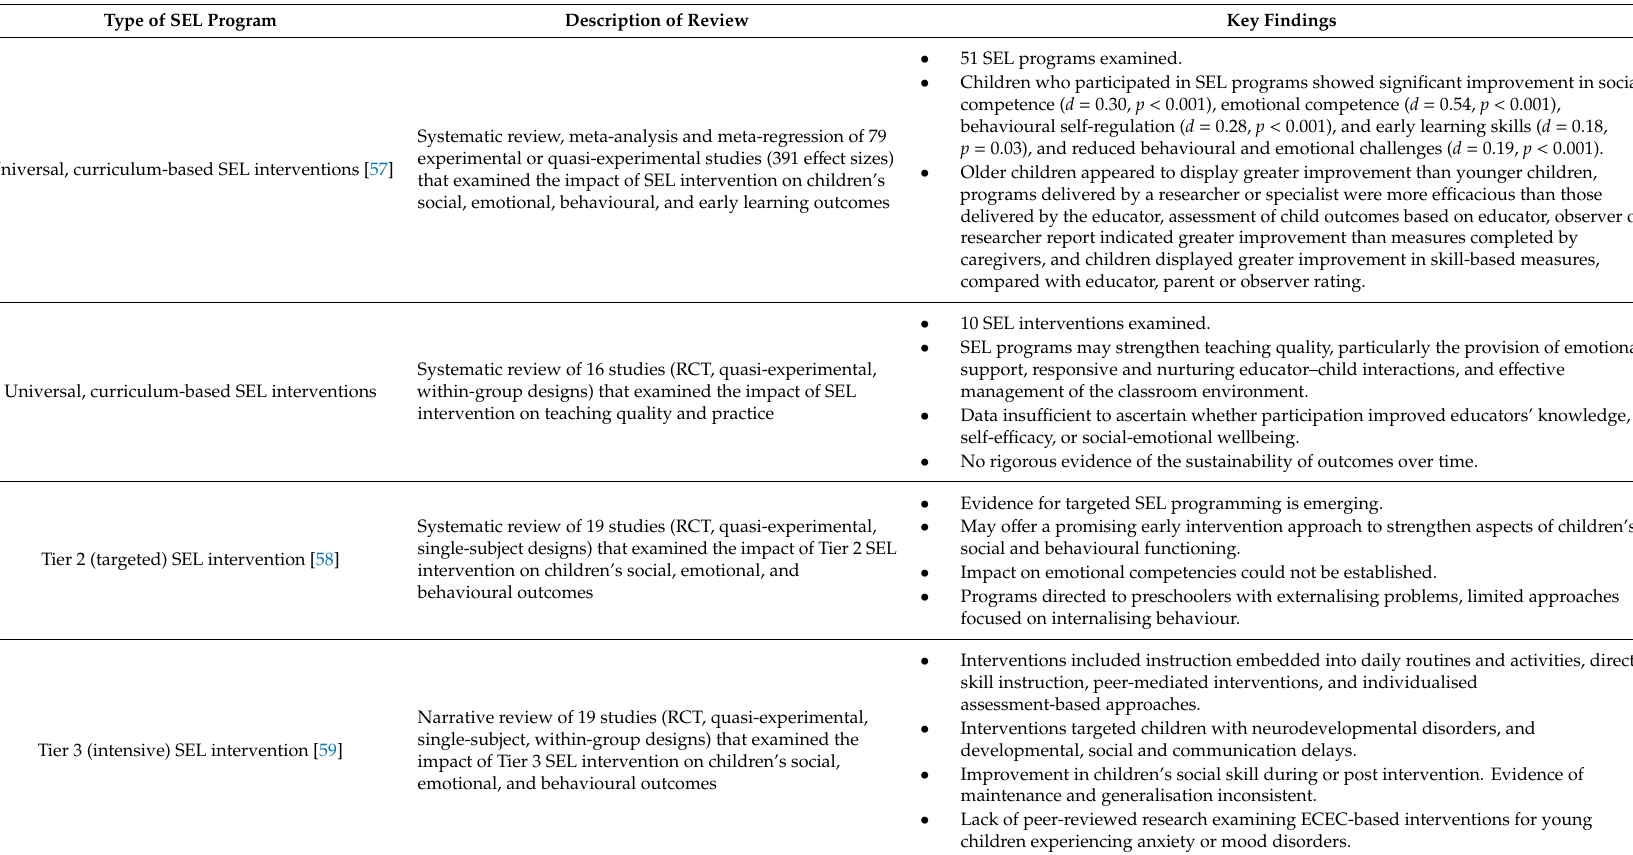
Table 1. Key Findings from Literature